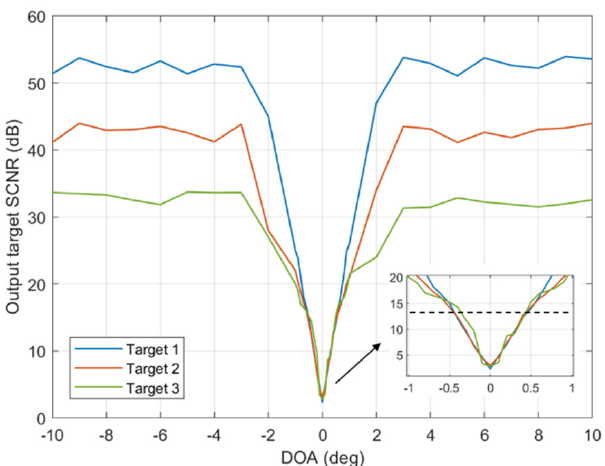
Figure 9. The output target SCNR as a function of DOA with Target 1, Target 2, and Target 3; the black dashed line indicates the normal detection threshold of 13 dB.